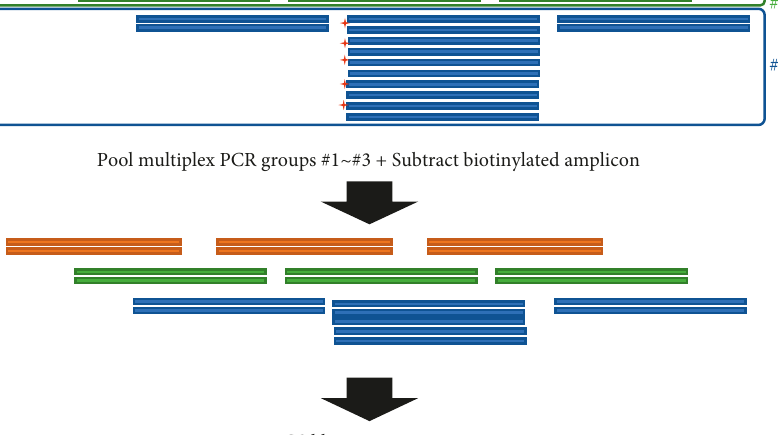
Figure 1: Workflow of the redundant tiling PCR. A schematic illustration of the redundant tiling PCR strategy for the whole-genome sequencing of SARS-CoV-2 is shown. Multiplex PCR was performed for three groups (orange, green, and blue amplicons) with no overlaps within each multiplex PCR. The primers used for this scheme are listed in Supplementary Table 1. After the first cDNA strand was synthesized via reverse transcription, it was subjected to tiling PCR. Using prior knowledge, consistently overrepresented amplicons were marked with biotin using biotinylated primers (red crossed marks) and subtracted from the multiplex PCR products via streptavidin- dependent subtraction. The subtracted multiplex PCR products were then used for NGS library